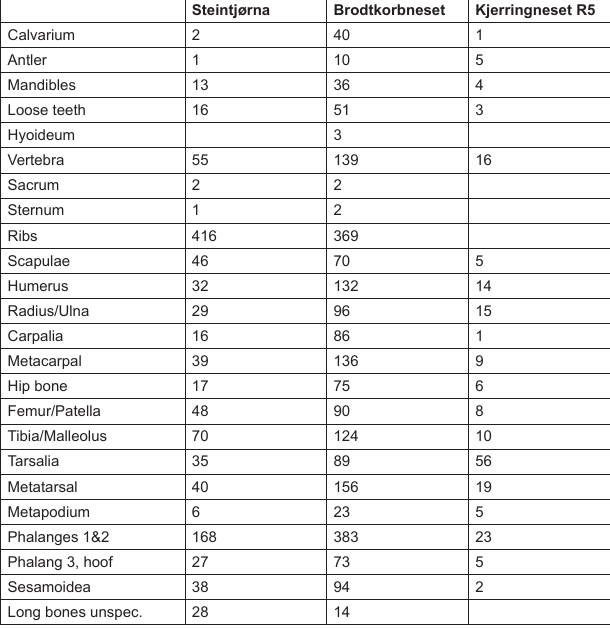
Table 5. Anatomical distribution of reindeer bones. Data from